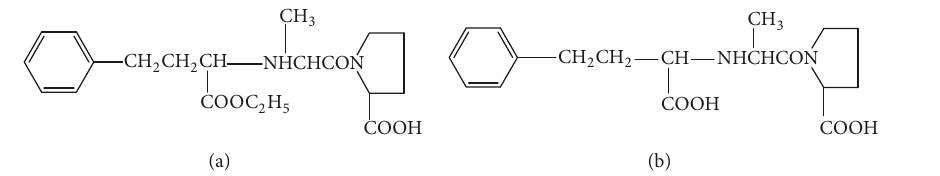
Figure 1: Structural formulae of (a) enalapril and (b) enalaprilat.